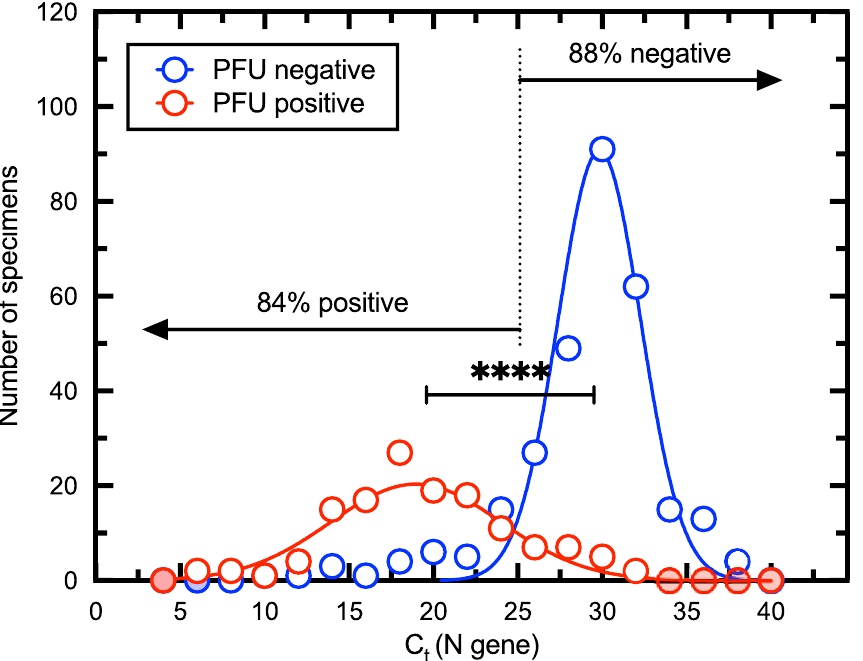
Figure 7. Relationship between C t and positive plaque assays. The specimens were divided into plaque-positive, and plaque-negative categories and the distribution of C t values calculated using bin steps of two. A non-linear fit of two Gaussian curves to these data is also shown. A sample with a C t ≤ 25 is 84% likely to bear infectious material while samples with C t > 25 are 88% negative. An unpaired t-test, using Welch’s correction for unequal variances and sample sizes, indicates that the two means (19.6 ± 5.1 SD versus 29.2 ± 4.2 SD) are significantly different (two-tailed P < 0.0001). Red or blue filled shading indicates that the binning process counted no specimens in these bins. Figure prepared using Prism v9.3 (https:// www. graph pad.